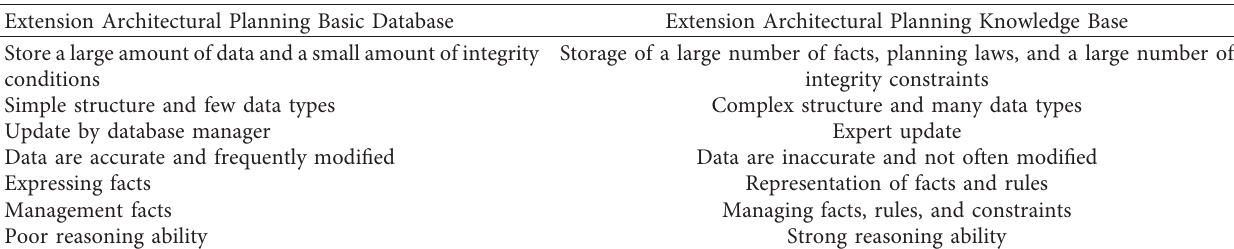
Table 1: Comparison of Basic Database and Professional Knowledge Base.